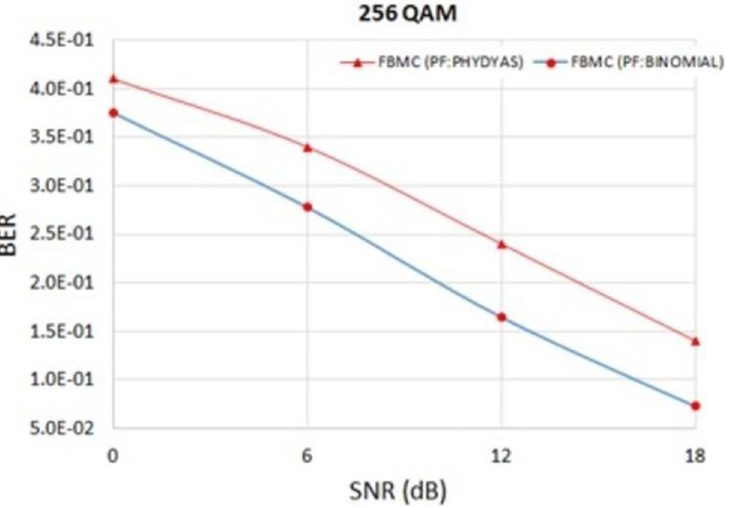
Fig 7. BER comparison at different SNR with Binomial and PHYDYAS filters of FBMC.